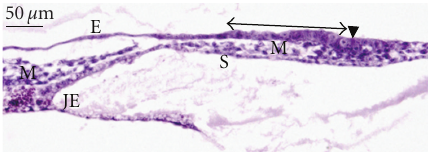
Figure 4: Section (plane indicated in Figure 2) through a chicken hemi-embryo cultured during 1 day. The arrowhead indicates a hemi-primitive groove in which upper layer cells ingress into the hemi-primitive streak, giving rise to a mesoblast mantle (M) which slides peripherally between the junctional endoblast (JE) and the epiblast (E); sickle endoblast (S); double-arrowed line indicates the surface of the thickened hemi-PS-forming upper layer. Hematoxylin eosin, bar = 50 μ m.